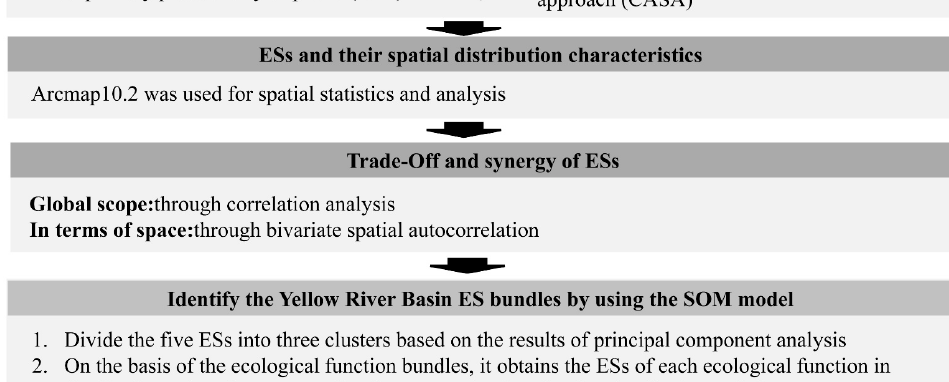
Figure 1. The framework of the methodological process.